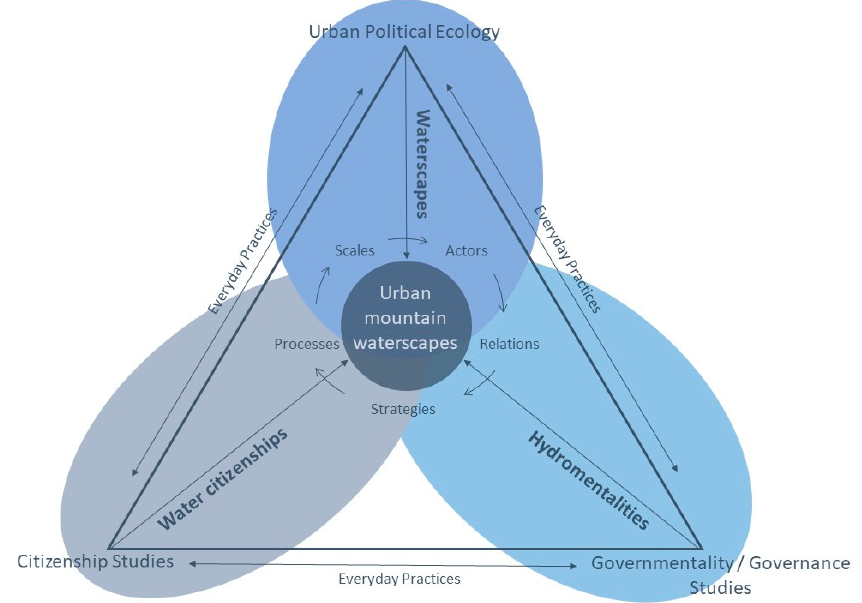
Figure 2. Conceptual framework (own draft).